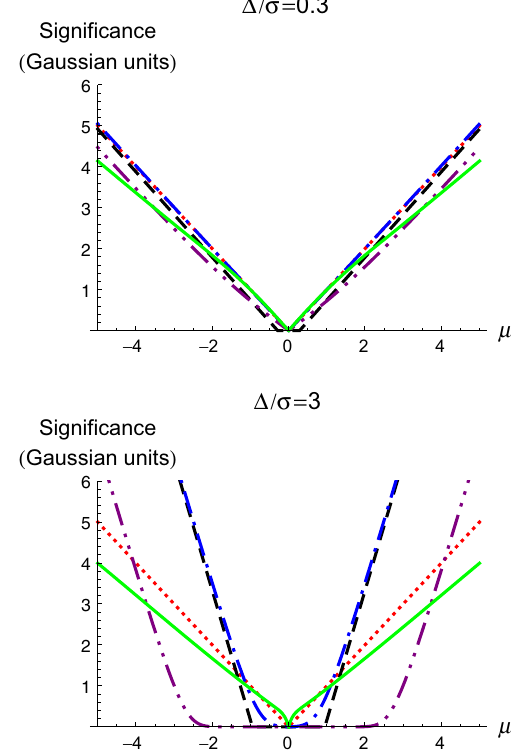
Fig. 4 Comparison of different treatments of theoretical uncertainties lowing the particle physics conventions. The various approaches are: of the measurement X = 0 ± σ ( exp ) ± Δ( th ) , with different val- nG ( dotted , red ), Rfit or 1-external ( dashed , black ), fixed 1-nuisance √ Δ 2 + σ 2 = 1). The p values ues of Δ/σ (with the normalization ( dotted-dashed , blue ), fixed 3-nuisance ( dotted-dotted-dashed , purple ), adaptive nuisance ( solid , green have been converted into a significance in Gaussian units of σ fol-